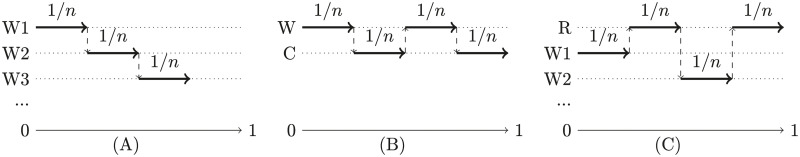
Patterns of interaction in the workplace.Horizontal movement represents production, vertical movement represents interaction. (A) Each worker W works on a range 1/n of tasks, passing work n − 1 times. (B) Worker W and customer C engage in frequent interactions. (C) Each worker W needs physical access to a key resource R.